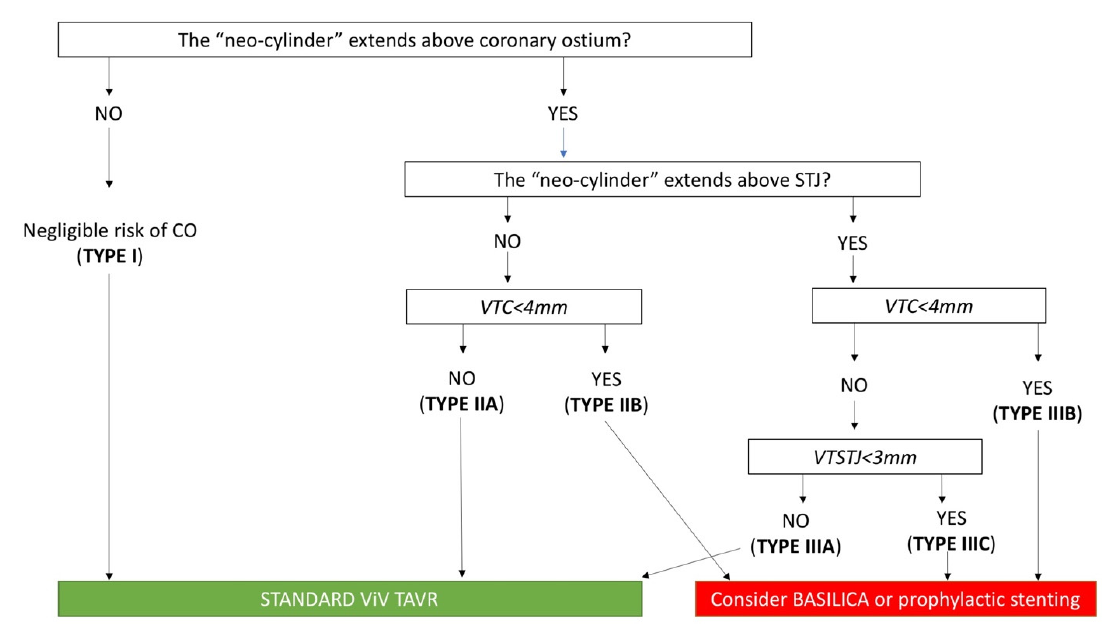
Figure 5. Risk of coronary artery obstruction during ViV TAVR according to VIVID classification . BASILICA: bioprosthetic aortic scallop intentional laceration to prevent iatrogenic coronary artery obstruction; CO: coronary obstruction; STJ: sinotubular junction; TAVR: trans- catheter aortic valve replacement; ViV: valve-in-valve; VTC: virtual-to-coronary distance; VTSTJ: virtual-to-sinotubular junction distance.